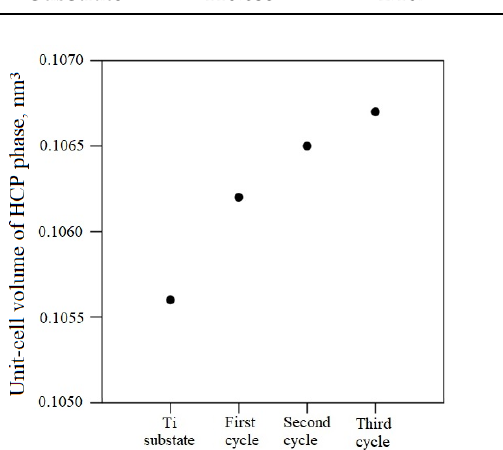
Figure 6. ( a )Young’s modulus and ( b ) hardness of the Ti substrate and the Ti-Ta coatings formed after each cycle.